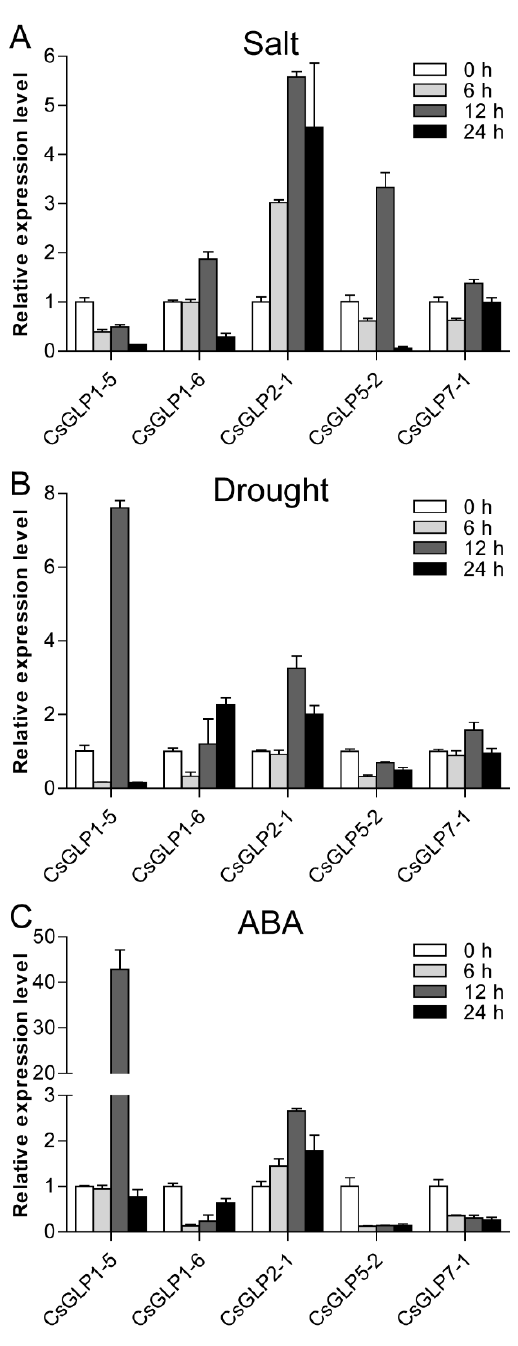
Figure 7. qRT-PCR analysis of expression patterns of five selected CsGLP genes in responses to salt ( A ), drought ( B ) and ABA ( C ) treatments. salt ( A ), drought ( B ) and ABA ( C )